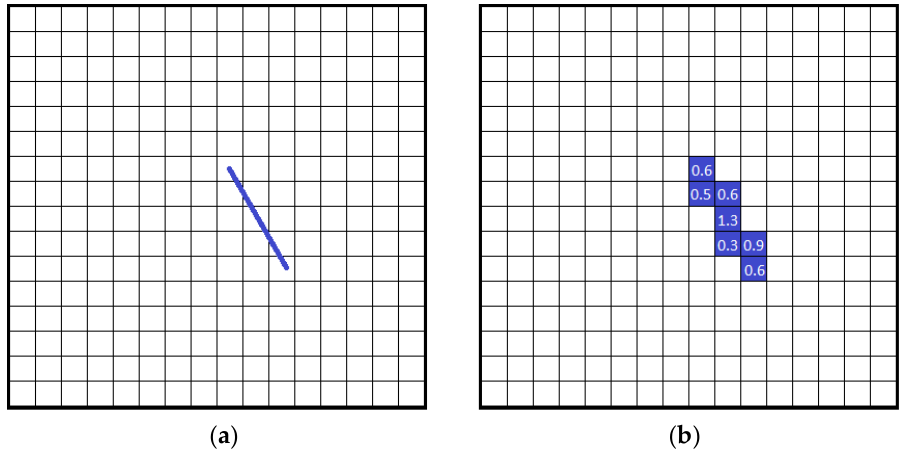
Figure 6. A discrete model of a CML. ( a )—a single CML of length 4.8 pixels, ( b )—its discrete representation.